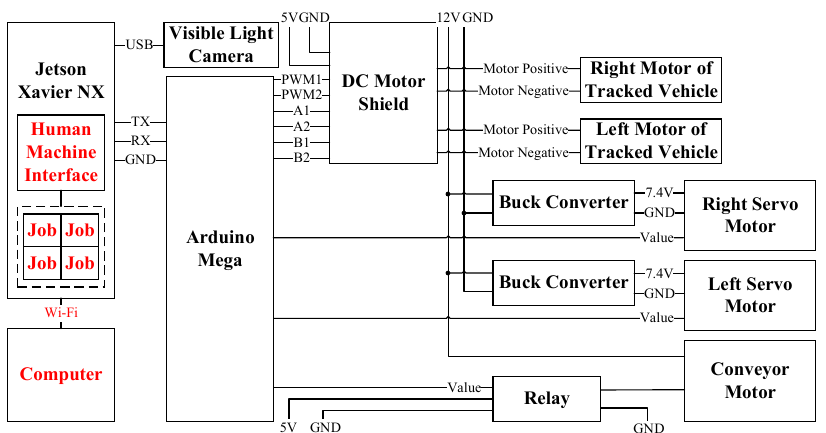
Figure 5. Hardware architecture of the designed system.